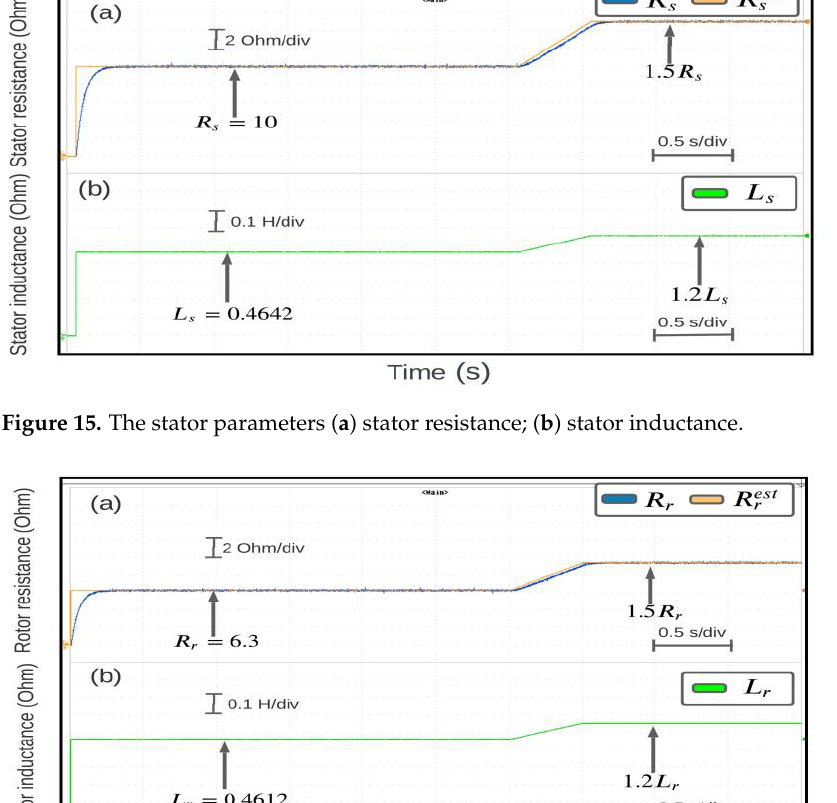
Figure 17. OeW-5PIM performance under rotor parameter changes ( a ) speeds responses; ( b ) esti- mation error.